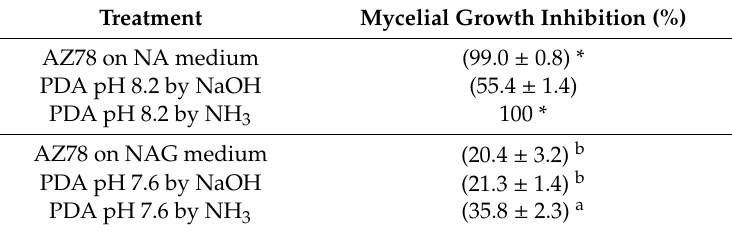
Table 3. Involvement of elevated PDA pH in Rhizoctonia solani growth inhibition by Lysobacter capsici AZ78. Treatment Mycelial Growth Inhibition (%)